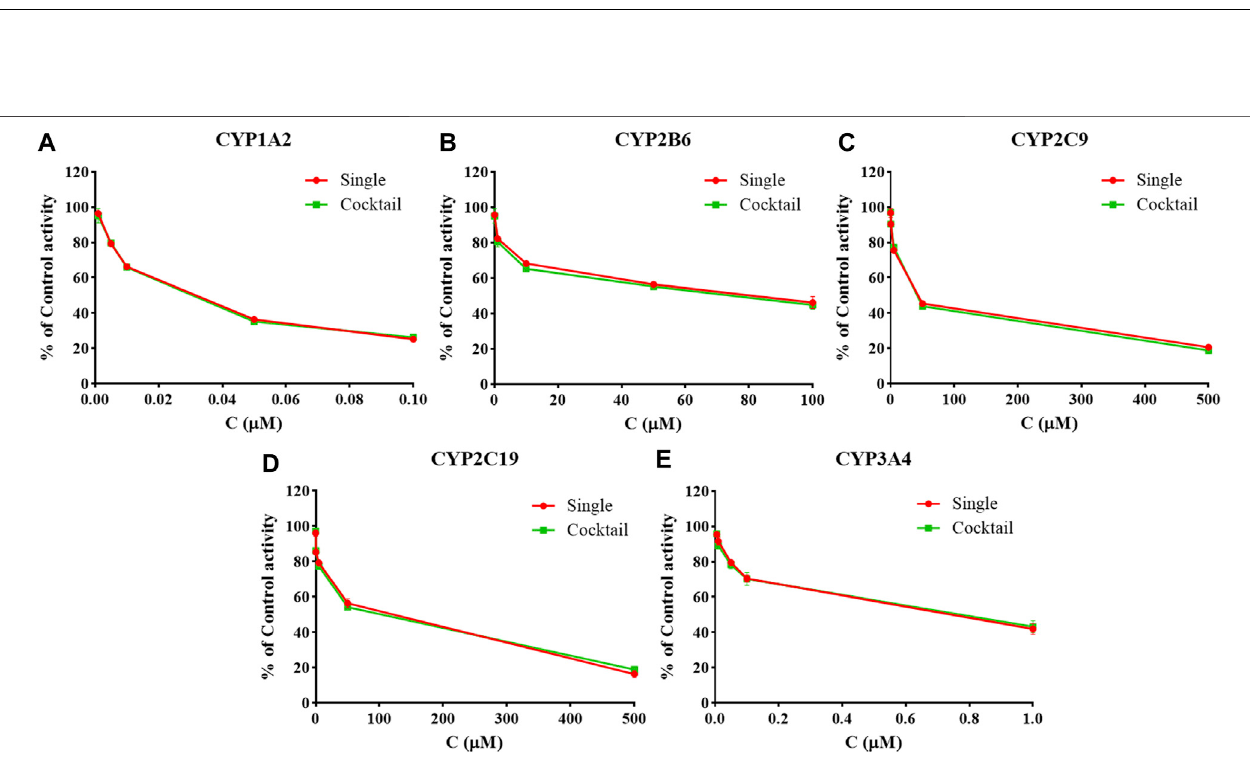
FIGURE 2 | The activities of CYP1A2 (A) , CYP2B6 (B) , CYP2C9 (C) , CYP2C19 (D) , and CYP3A4 (E) in the hiHeps model between single probe substrates and cocktail probe substrates (mean ± SD, n (cid:2) 3).